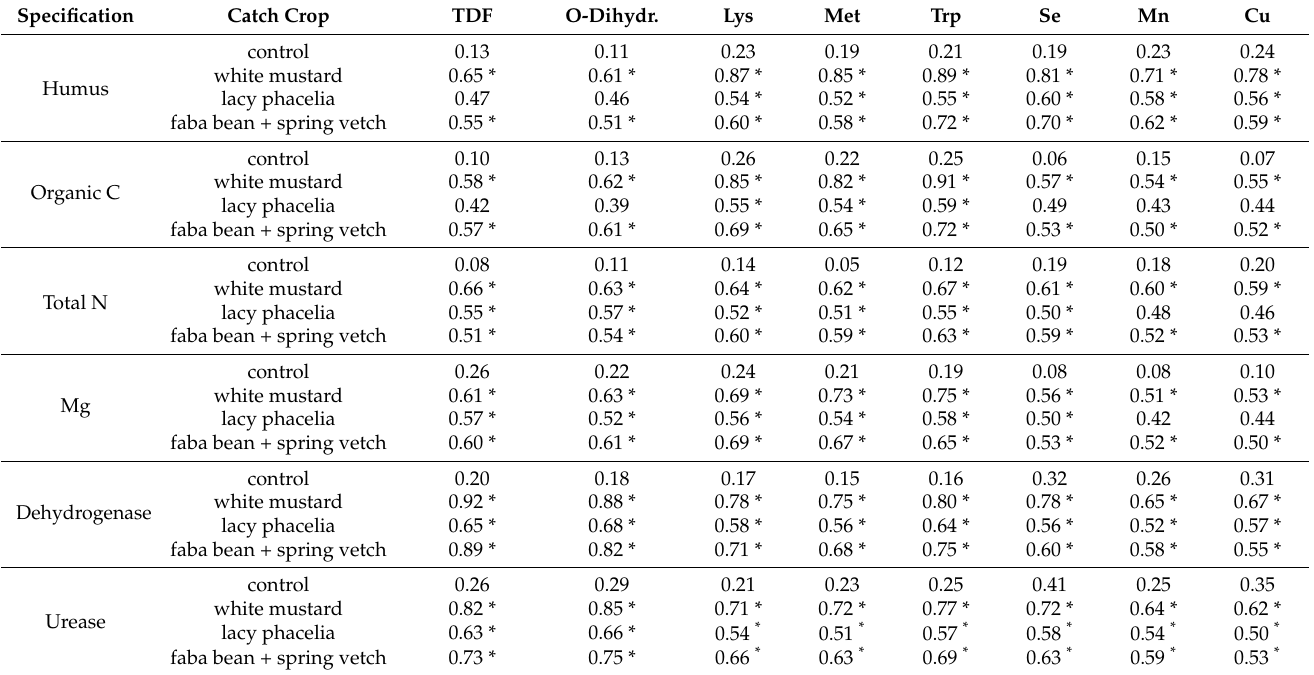
Table 11. Coefficient of correlation (r) for some soil chemical components and soil enzymatic activity in relation to selected quality characteristics of spring wheat grain (under catch cropping conditions, regardless of the tillage system).